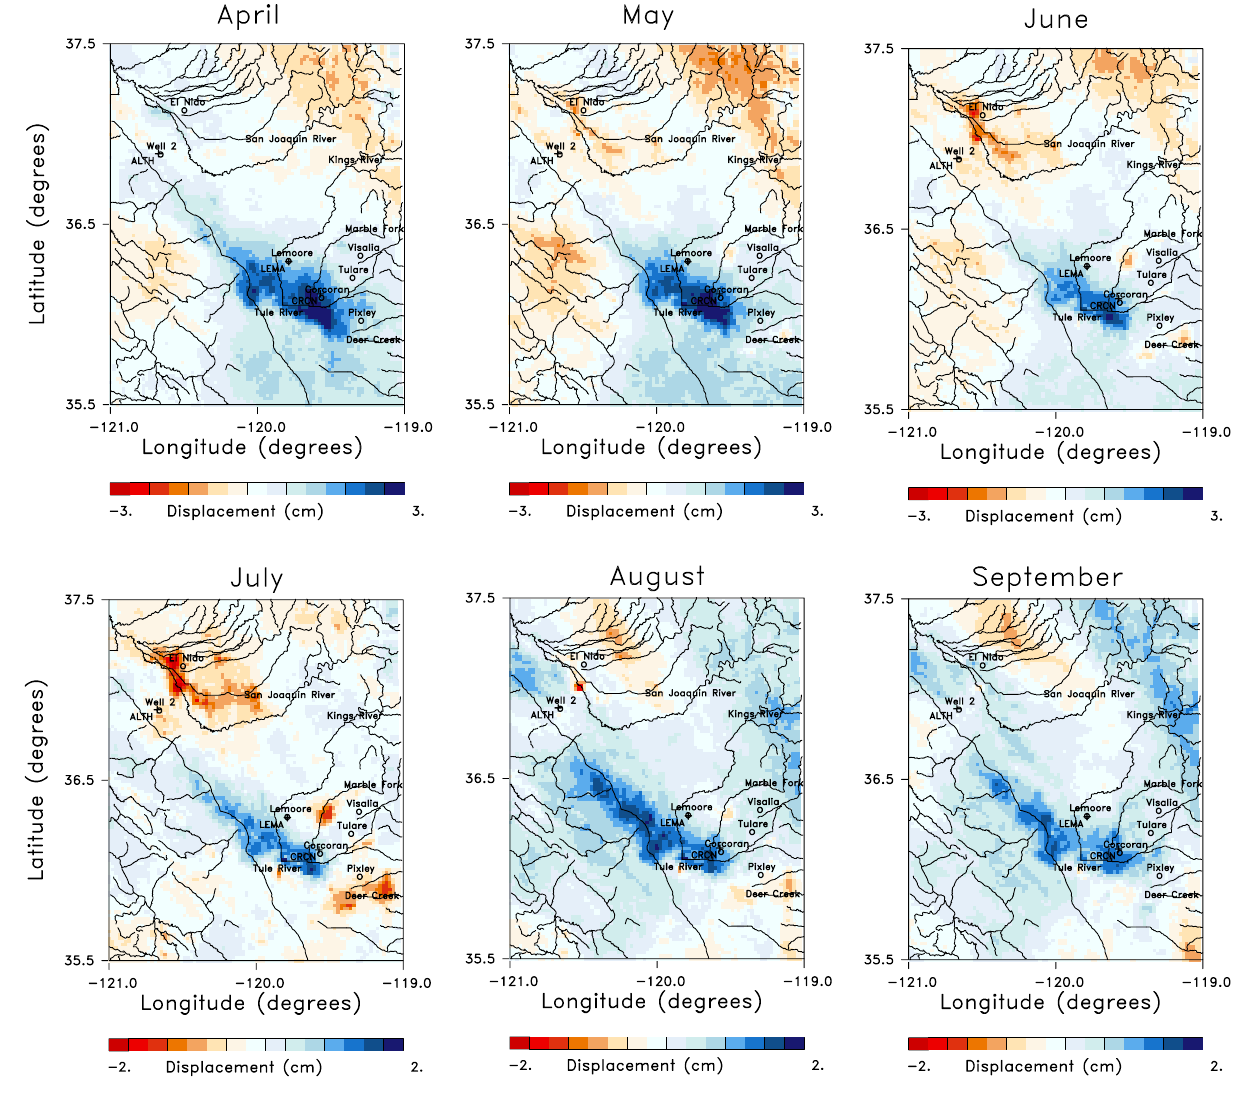
Figure 5. Panels displaying 6 sequential instances of monthly line-of-sight displacements for months in 2017. The plots were constructed using NCL and NCAR Graphics 6.5.0 (https:// www. earth syste mgrid. org/ datas et/ ncl. 650.